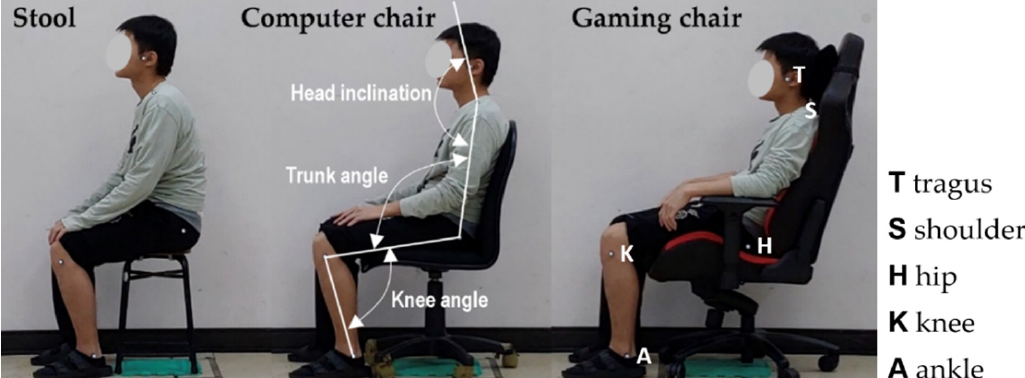
Figure 1. Three types of chairs and global joint angles examined in the test.